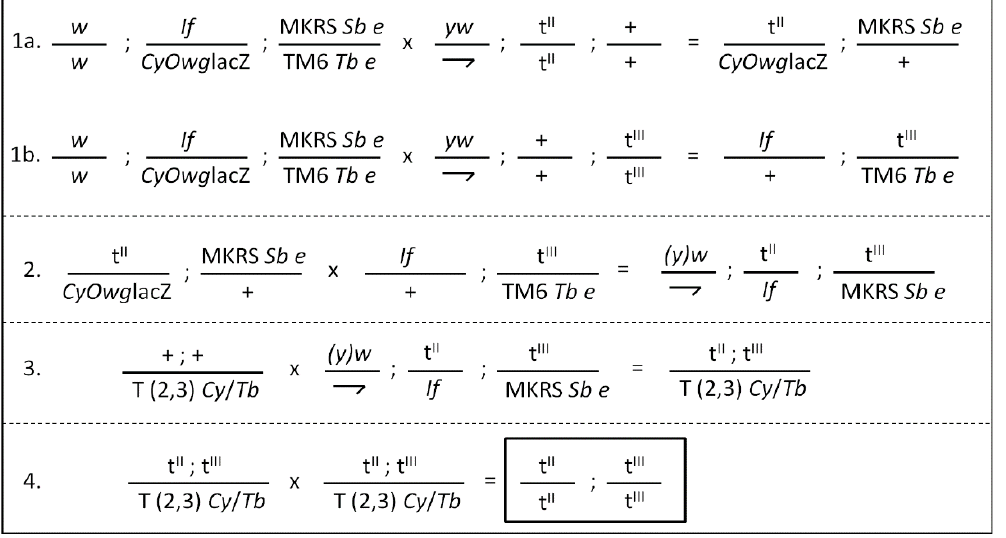
Figure 1. Generic crossing scheme for the generation of strains bearing two transgenes (either HR-GAL4 and UAS-CYP392A16 or UAS-CYP392A16 and UAS-TuCPR) in the 2nd (t II ) or 3rd (t III ) chromosome, respectively. Since all types of transgenic flies were originally generated by P-element mediated transgenesis at random (unknown) positions, crosses among several different lines were performed to account for position effects. Virgin multiple-balancer females were crossed with homozygous transgenic males bearing the relevant transgenes at the 2nd chromosome (cross 1a ) or the 3rd chromosome (cross 1b ) and the progeny with the indicated genotype from each cross was used for the cross ( 2 ) in order to bring both transgenes opposite to the selected markers If and Sb (note that the chromosomes bearing these markers are not balancers). Male progeny (not undergoing recombination) was crossed with virgin females from a double-balancer strain bearing a rearranged T(2,3) chromosome marked with both Cy and Tb (cross 3 ) and the progeny was selected against If and Sb to identify individuals expected to have both transgenes opposite to the T(2,3) Cy / Tb balancer. These were intercrossed (cross 4 ) to provide the homozygous strains (shown in box) bearing both UAS-CYP392A16 and UAS-TuCPR or both HR-GAL4 and UAS-CYP392A16, following selection against Cy / Tb markers. Note that, in the HR-GAL4 line available, the transgene is located at the 2nd chromosome.